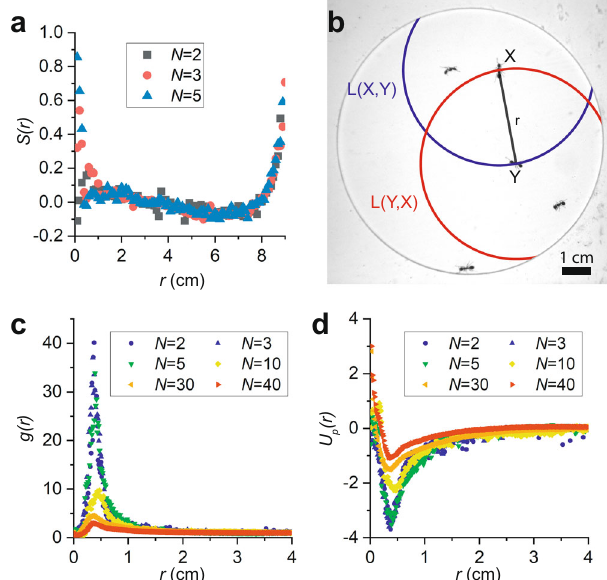
Fig. 5 | Alignment and pair correlations. a Alignment between pairs of ants demonstratedbytheorderparameterforpairsatvariousdistances. b Illustrationof theavailablearclength.Theredlineshowstheavailablearclength, L ( Y,X ),forant Y tobefoundadistance r awayfromant X andthebluelineshows L ( X,Y ). c Calculated pair correlation function after using our geometric correction for different N . d Potentials of Mean Force for different N .